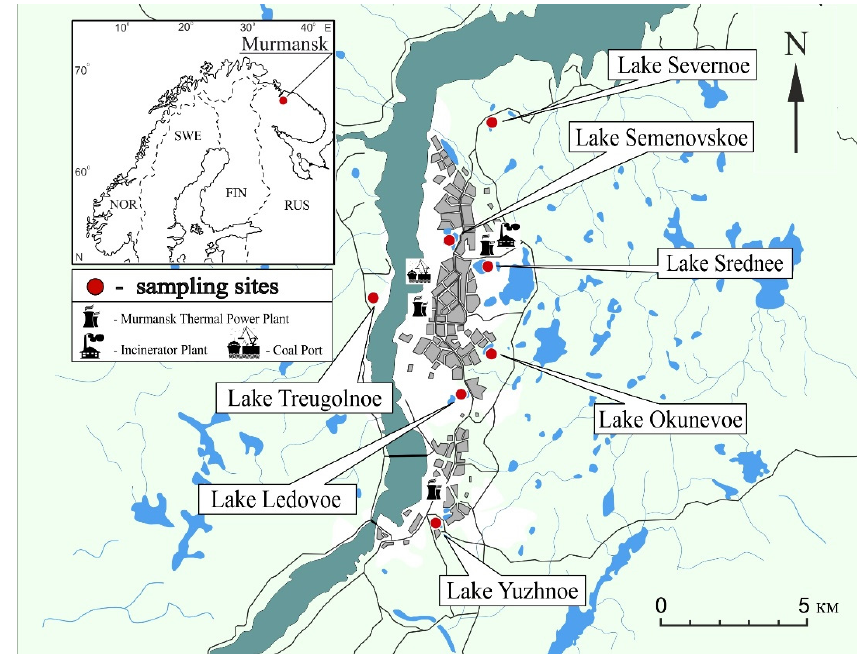
Figure 1. Schematic map of the location of research objects.